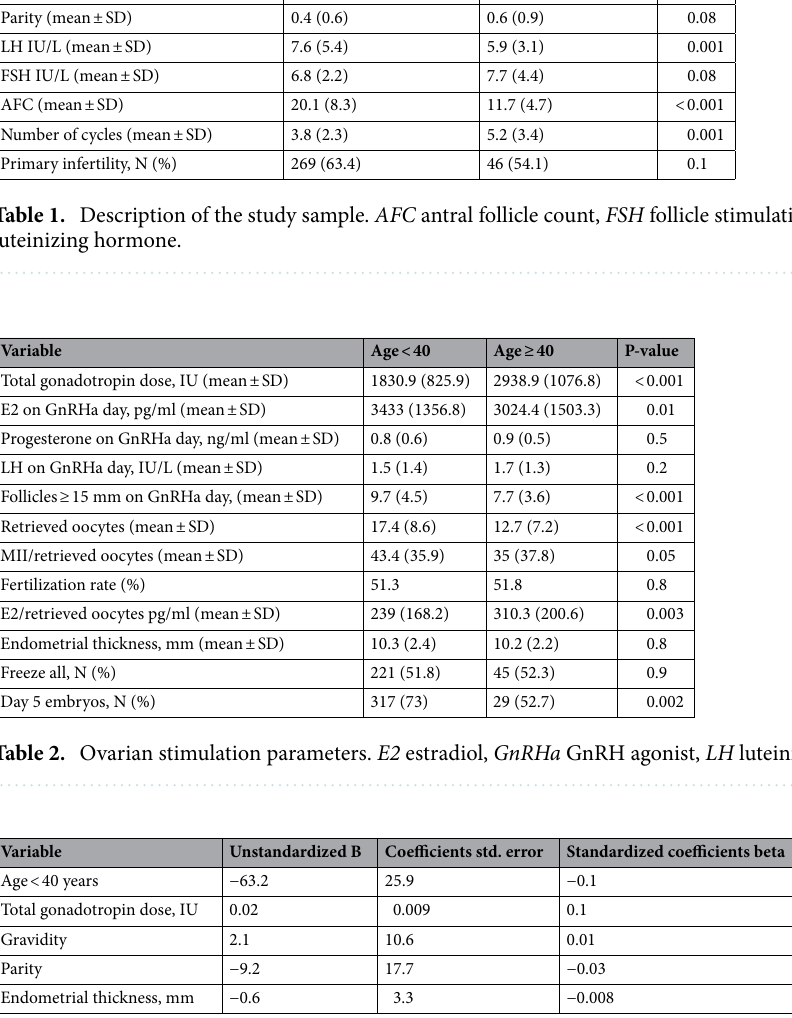
Table 3. Multivariable logistic regression analysis for E2/retrieved